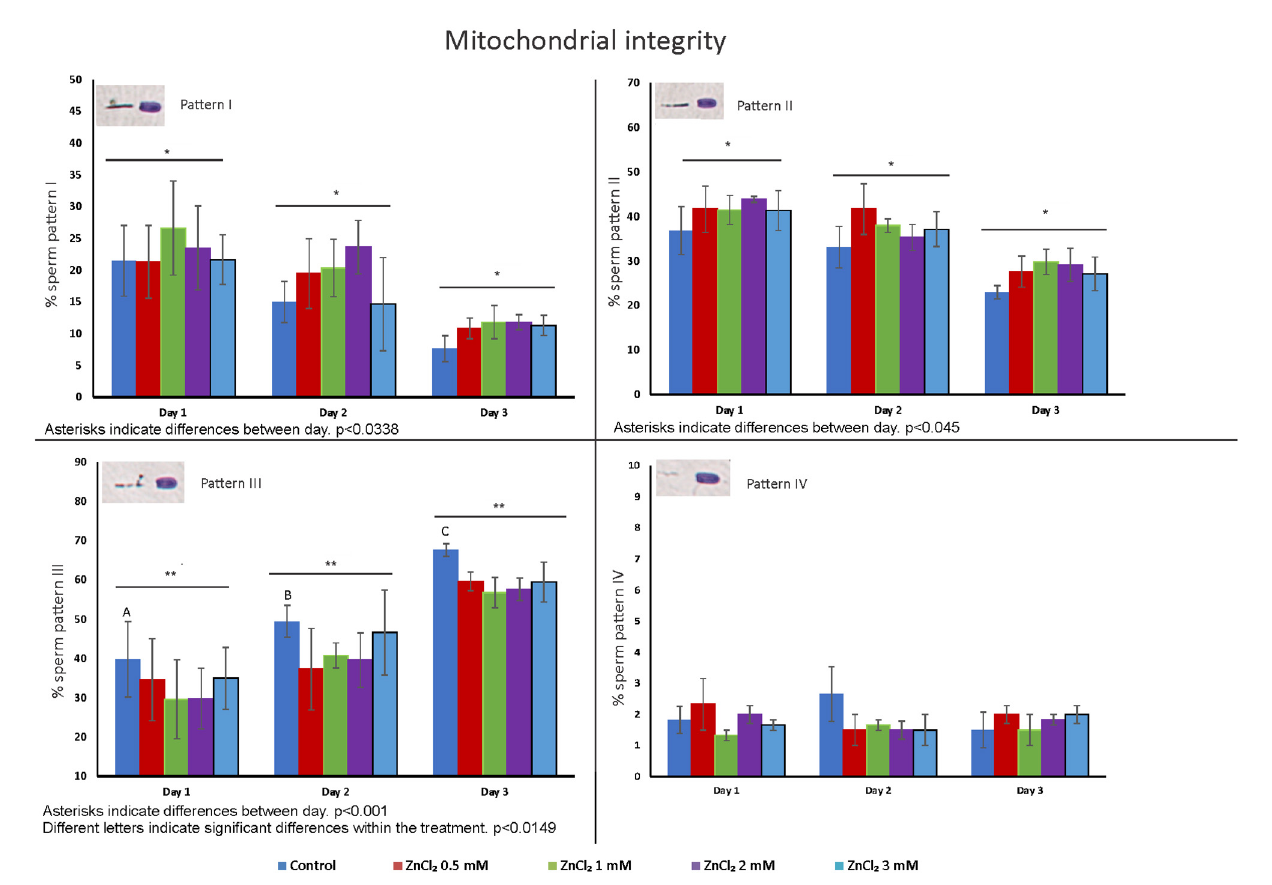
FIGURE3 Distribution of cells with staining patterns that report on mitochondria activity. Seminal doses were supplemented with ZnCl 2 and stored for 1, 2, and 3 days. The graphics show the means of percentage of each pattern of staining of the midpiece based on cytochrome c oxidase activity ± standard error. Asterisks show significant differences between days ( p = 0.038, p = 0.045 and p = 0.001 for pattern I, II, and III respectively) and letters show significant differences between treatments ( p = 0.0149) ( n = 8). Cells displaying Pattern I maintain full mitochondrial activity. Cells displaying Pattern II